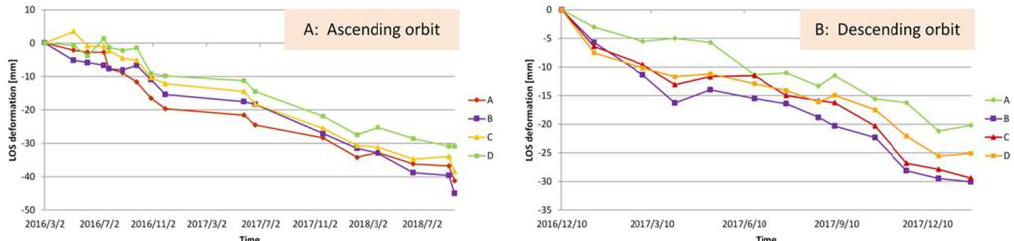
Figure 17. The dam top deformation series results of the CSK-SM data sets by the stacking method: ( a ) Points on the downstream slope in the ascending orbit and ( b ) Points on the upstream slope in the descending orbit.